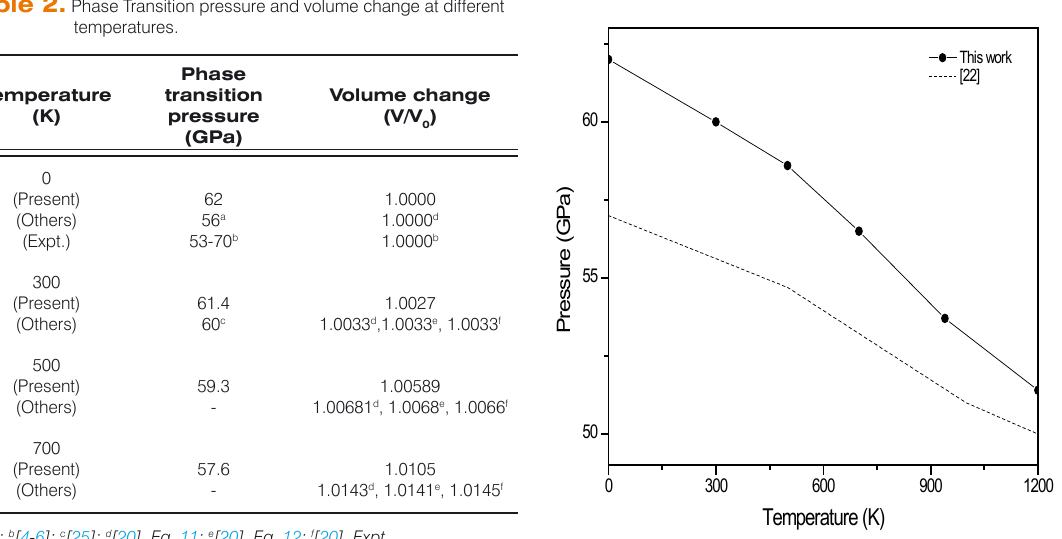
Fig. 4 Figure 4. Variation of transition pressure with temperature.